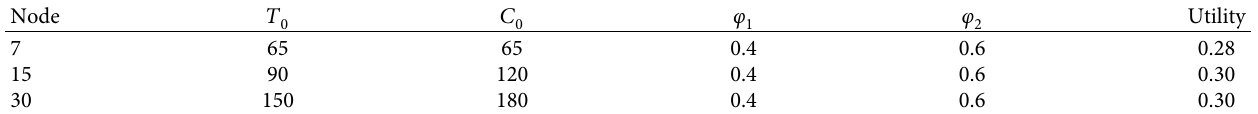
Table 8: Model parameter combination and the best utility of different node